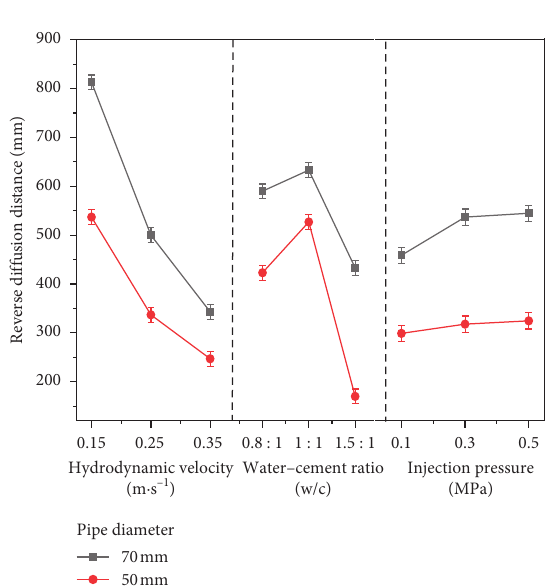
Figure 8: Influence of various factors on the reverse diffusion distance of the